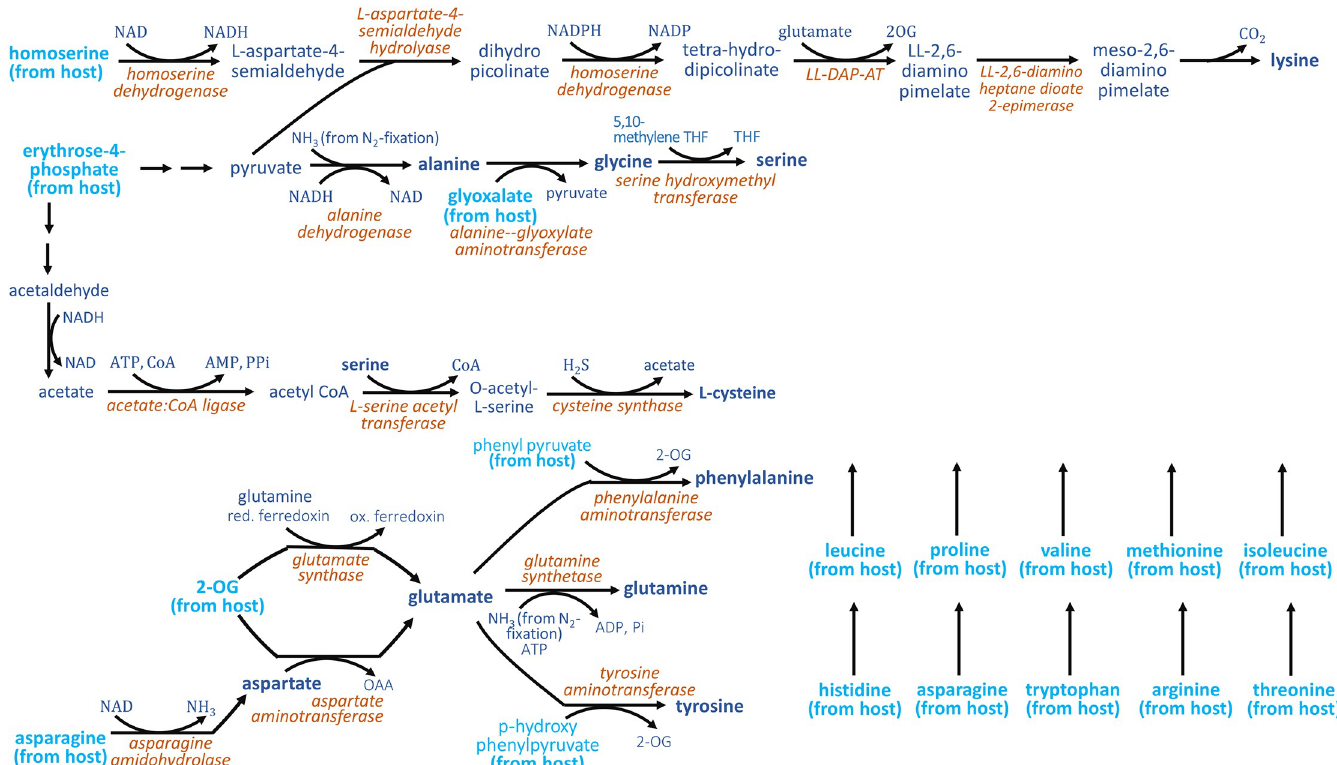
Fig 2. Amino acid biosynthesis in UCYN-A. Overview of amino acid biosynthesis and predicted import in UCYN-A. Metabolites synthesized by UCYN are shown in blue, and metabolites transferred from the host in cyan. Enzyme names are shown in orange.